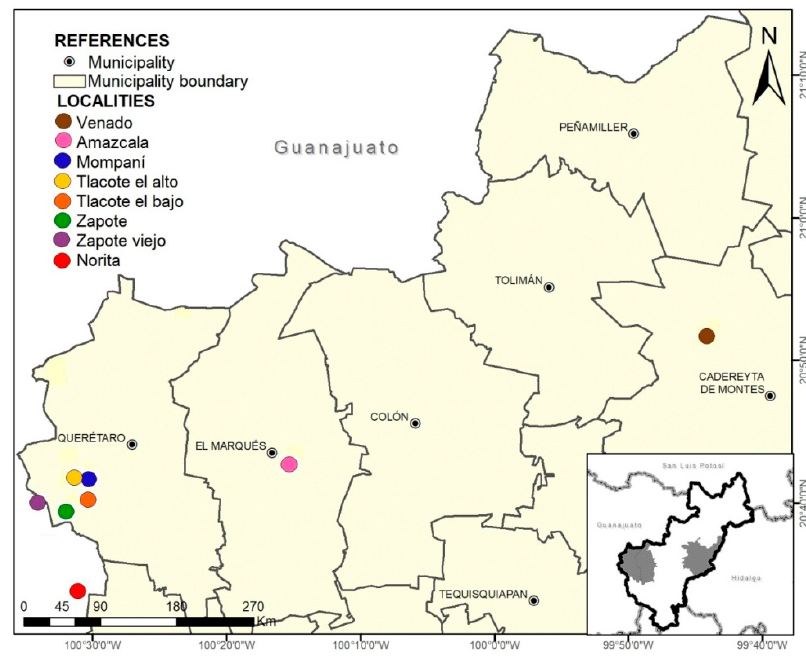
Figure 1. Localities where the herds included in the study were located.